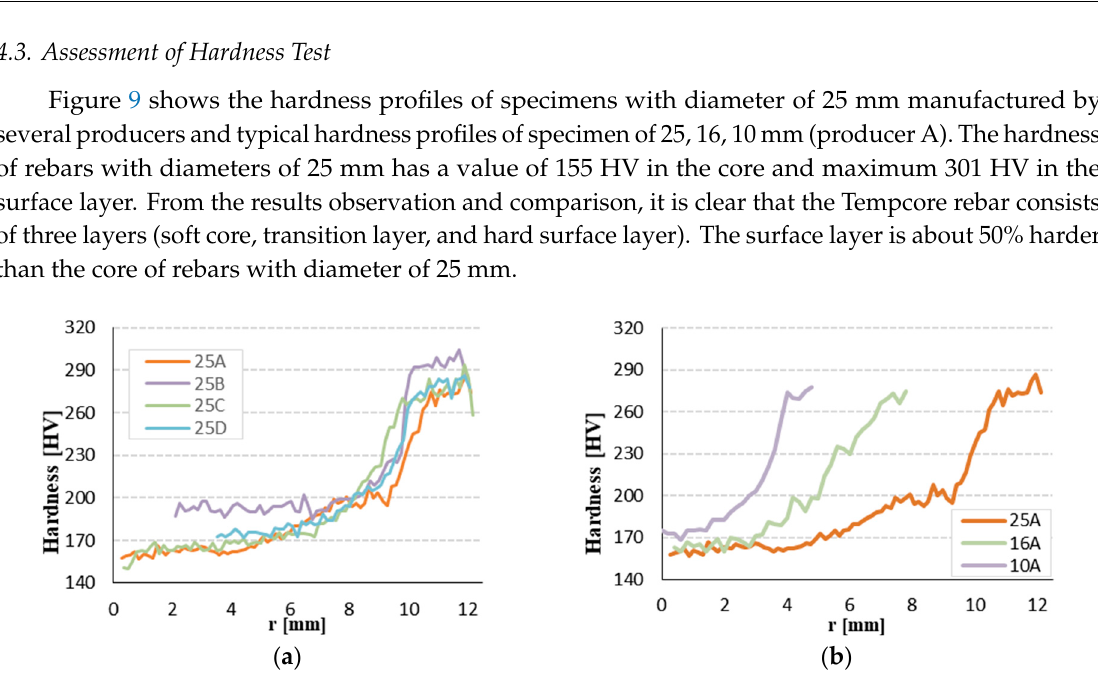
Figure 9. Hardness measurements: ( a ) different producer φ 25 mm and ( b ) φ 10, 16, 25 mm rebar.